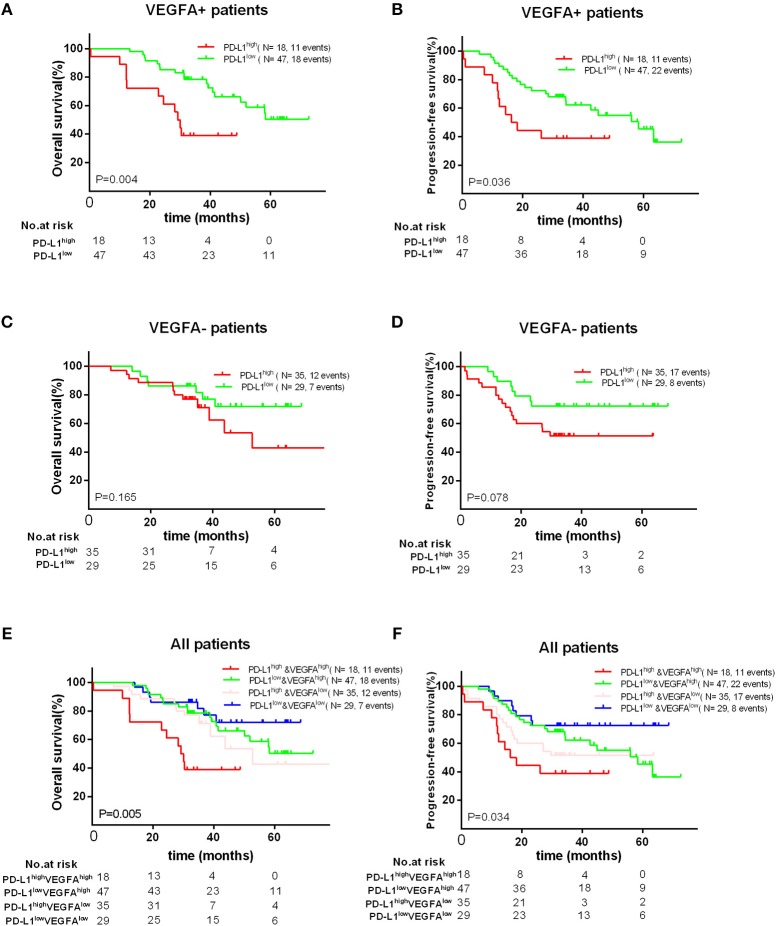
Kaplan–Meier curves showing OS (A,C) and PFS (B,D) of different groups (VEGFA+ or VEGFA-) with high and low of PD-L1 expression, showing OS (E) and PFS (F) in patients with PD-L1–&VEGFA–, PD-L1+&EVGFA–, PD-L1–&VEGFA+ and PD-L1+&VEGFA+ expression.